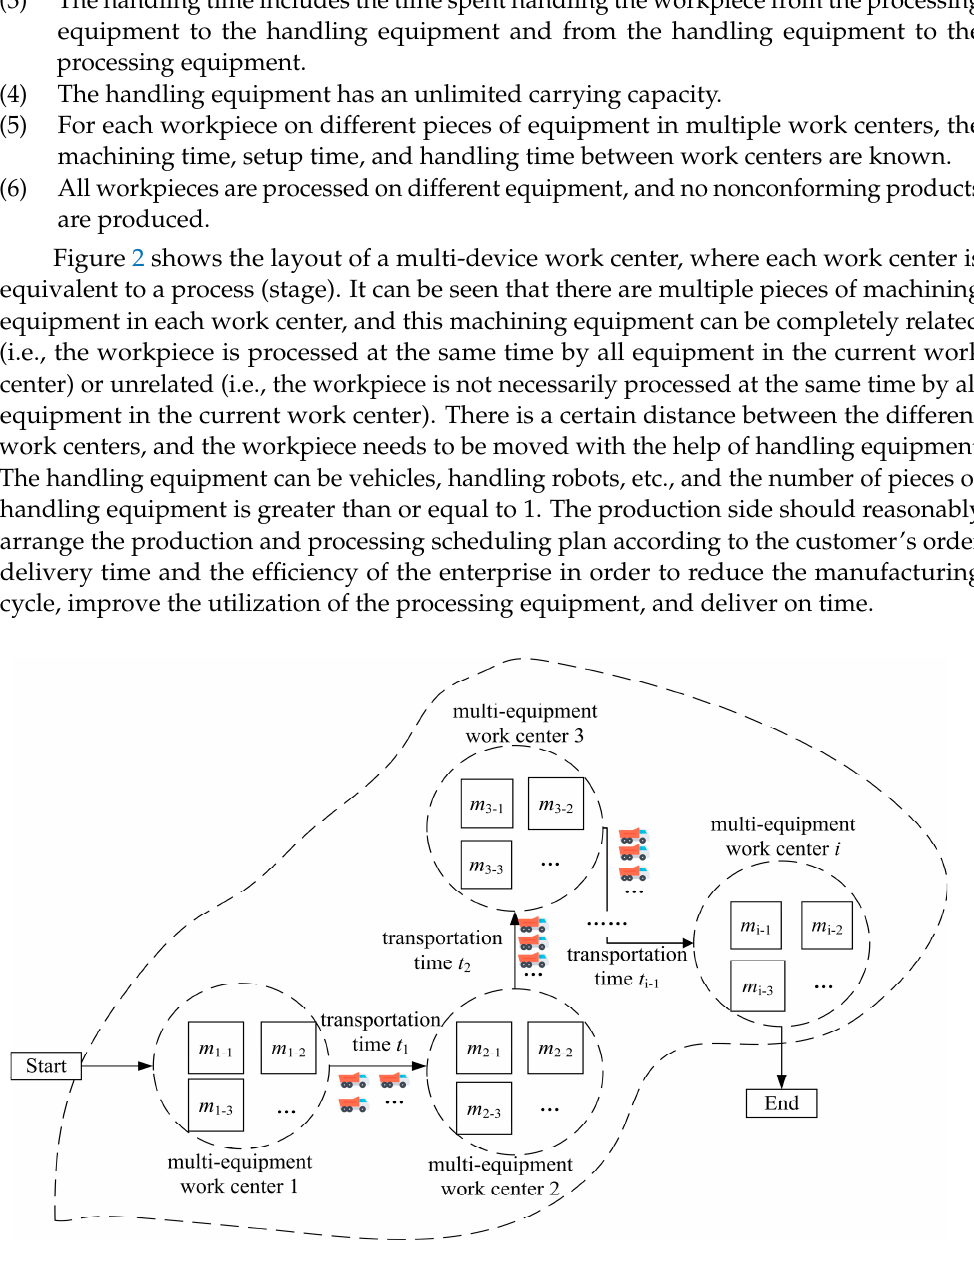
Table 1. Definition of parameters.